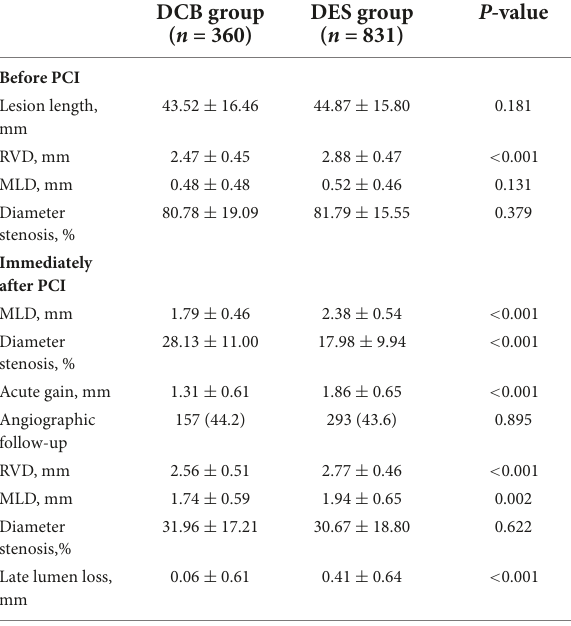
TABLE 4 Quantitative coronary angiography measurements.